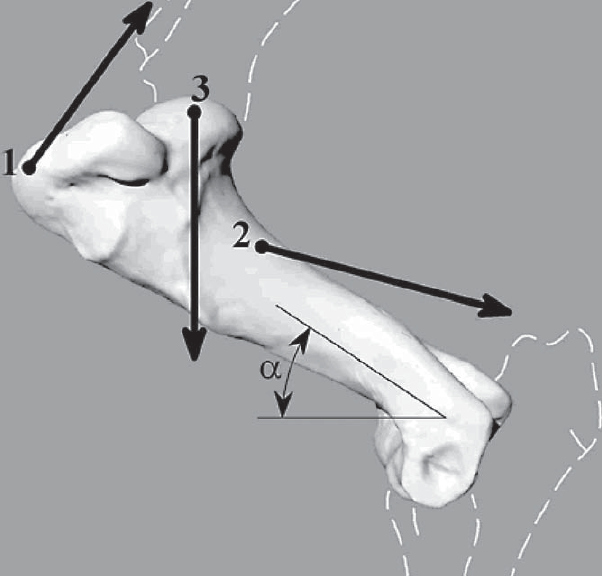
Fig. 5. Considered forces acting on humerus, with their application points and action directions. (1) Total force carried out by supraspinatus, infraspinatus, pectoralis and subscapularis muscles. (2) Triceps brachialis muscle force. (3) Cow weight plus impact force. ( (cid:2) ) Angle formed by the axis of the humerus with the horizontal plane. Dashed lines represent the adjacent bone ends, scapula and radio-ulna. Table 1 Forces obtained for each muscle and for each muscle group consid- ered, in function of its own section